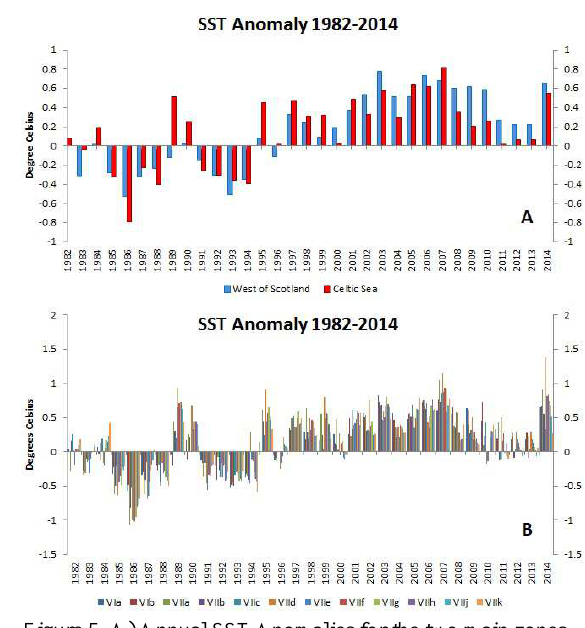
Figure 5. A) Annual SST Anomalies for the two main zones analysed in the study: West of Scotland and Celtic Sea. B) Annual SST Anomalies for every ICES Division. The climatology used to compute the daily OISST anomalies used in this study represents the 1971–2000 base